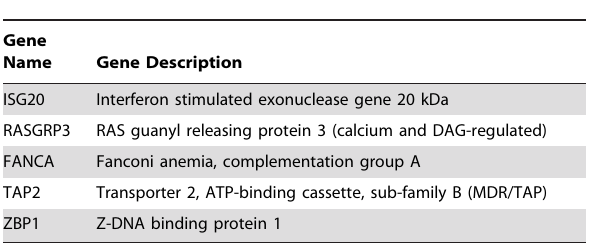
Table 1. Differentially expressed genes in virus-stimulated versus unstimulated cells for smallpox vaccine based on ReliefSeq that significantly overlap (p =6.25e-5) with stimulated versus unstimulated differentially expressed genes in yellow fever vaccine in the Molecular Signatures Database